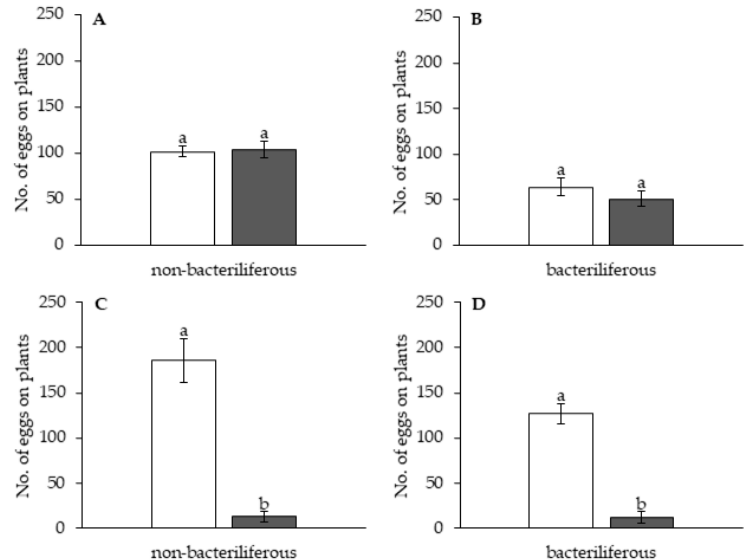
Figure 2. Average number of eggs ( ± SEM) laid by bacteriliferous and non-bacteriliferous Dalbulus maidis females on leaves of healthy “mock-inoculated” (white bars) vs. maize bushy stunt phytoplasma (MBSP)-infected (black bars) maize plants during 24-h choice assays. Infected plants were either in the asymptomatic ( A , B ) or symptomatic ( C , D ) phase of the disease. Means with the same lowercase letters are not statistically di ff erent by the t -test ( A , B ) or Kruskal–Wallis test ( C , D ) ( p <